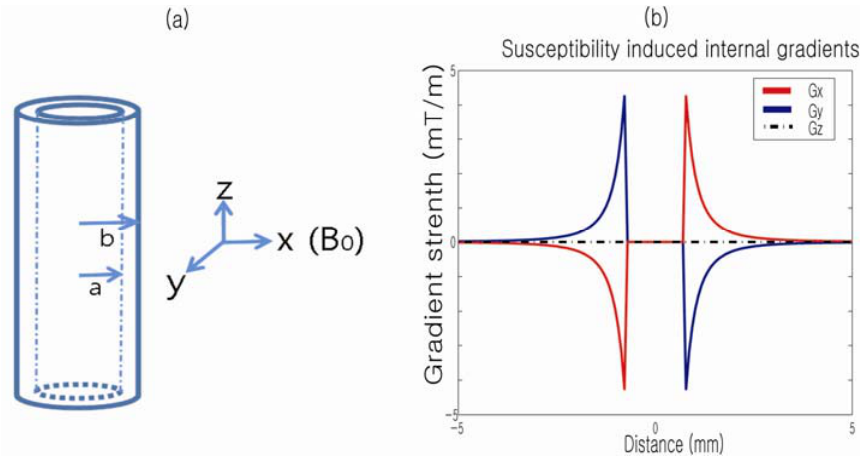
Figure 4. ( a ) Capillary cylinder in the presence of (diameter: 1.55 mm; wall thickness: 0.2 mm); ( b ) Calculated susceptibility-induced internal gradients along the x , y and z directions. Reproduced from Reference [43] with